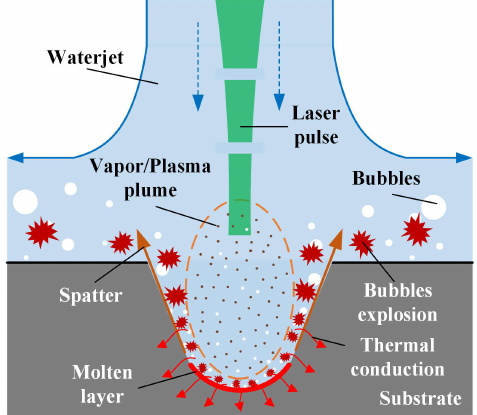
Figure 3. Working principle of coaxial waterjet assisted laser scanning machining (CWALSM).